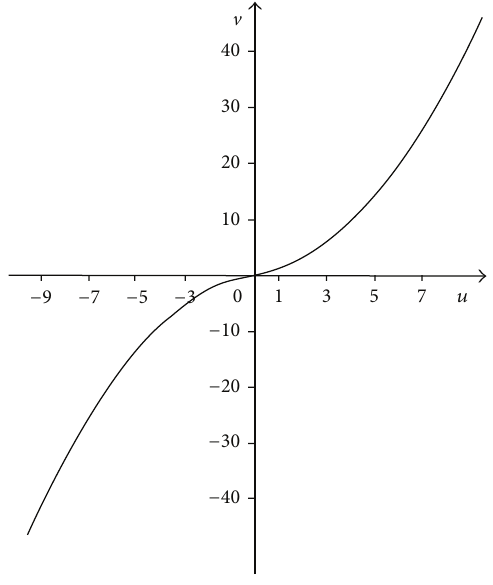
Figure 2: Dependence V = V (𝑢) in